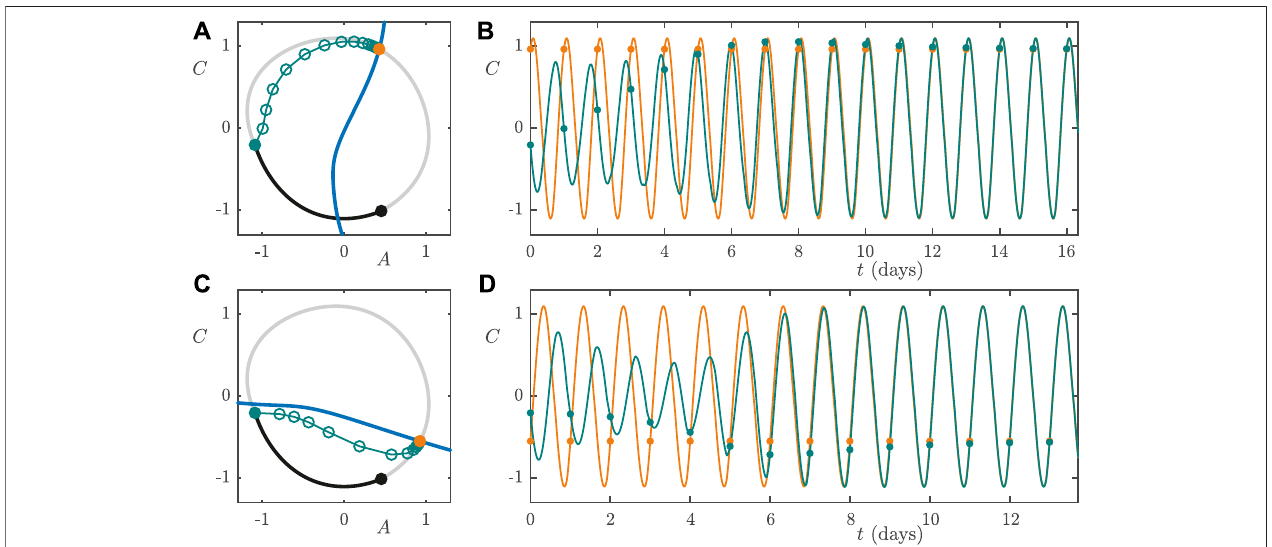
FIGURE12| Highlux( I (cid:1) 1000)entrainmentdynamicsfor τ c (cid:1) 24 . 2and N (cid:1) 17.Panelorderandformatarethesameasin Figure11 . (A) + (C) :Noteherethatonly the stable periodic orbitexists, and the starting point for the re-entraining trajectory (solid teal dot) in panel (C) is close to the stable manifold (blue curve) that constitutes the “ shortcut ” to entrainment. See the Supplementary Material for movies of the entraining trajectories.